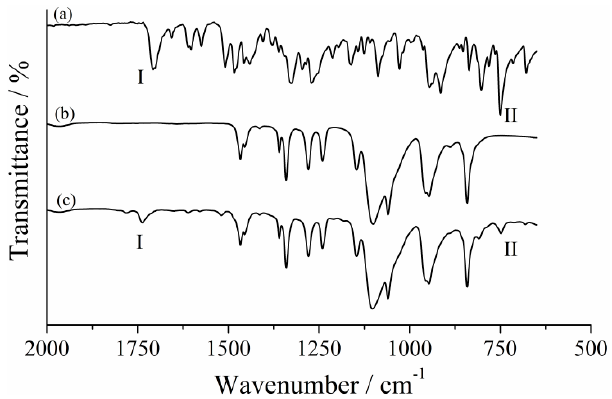
Figure 2. FTIR-ATR spectra of ( a ) SPCOOH, ( b ) PEG 2000 and ( c ) PEGSP2.